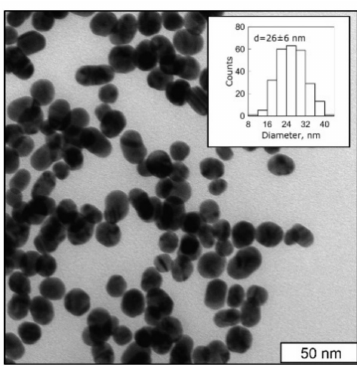
Figure A1. TEM image and size distribution of synthesized Au